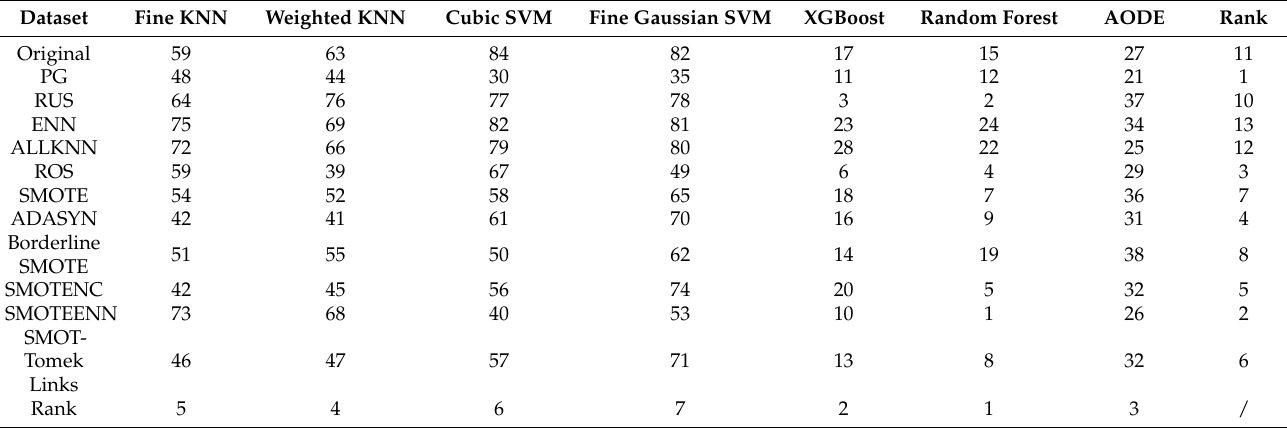
Table A2. Ranking results based on Score